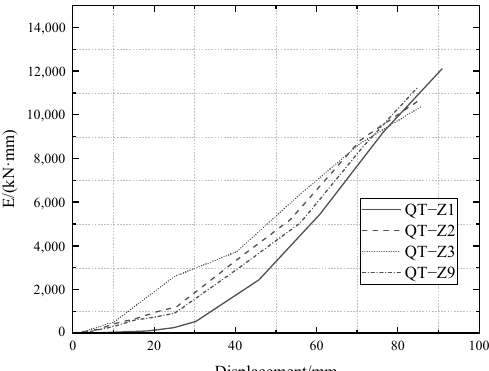
Figure 22. Energy consumption curves.